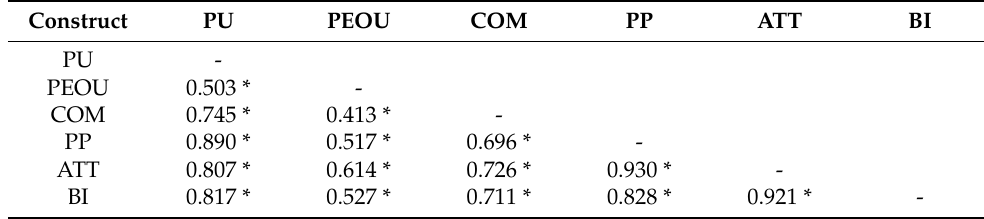
Table 2. Pearson correlation coefficient matrix.